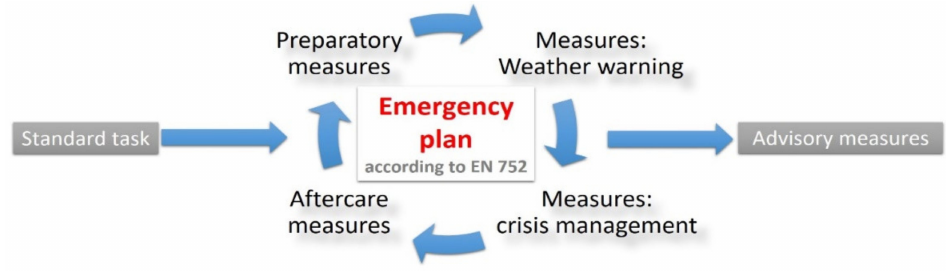
Figure 2. The process of “dealing with heavy